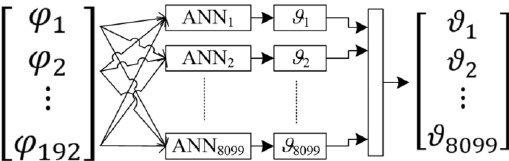
Figure 12. The scheme of converting electrical signals into the image pixels.